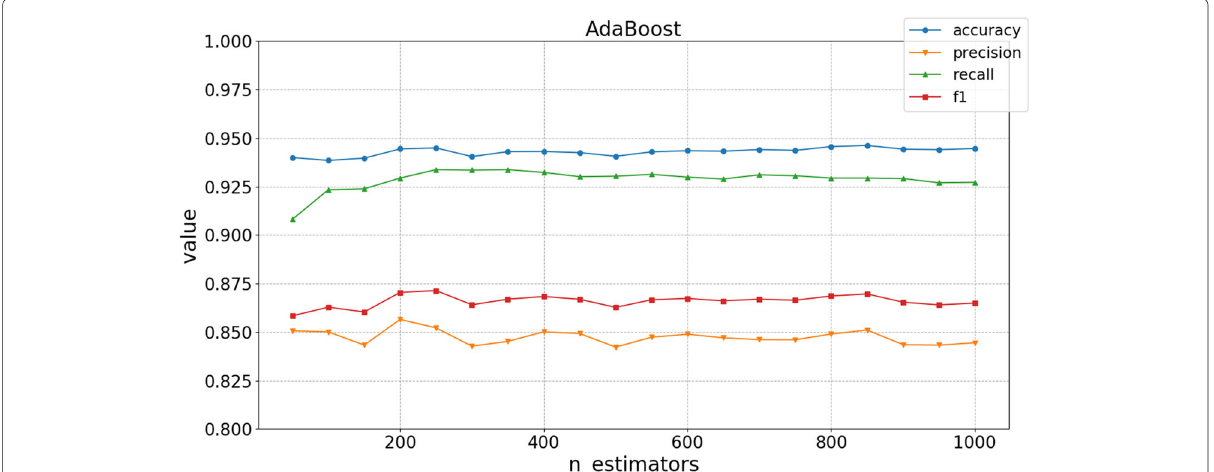
Fig. 5 Result of AdaBoost with regard to n _ estimators . The four metrics displayed in this figure are above 82.5%, and their values increase slightly when the value of n _ estimators increases. The accuracy is close to 94%. When n _ estimators is about 250, the system obtains a relatively optimal performance